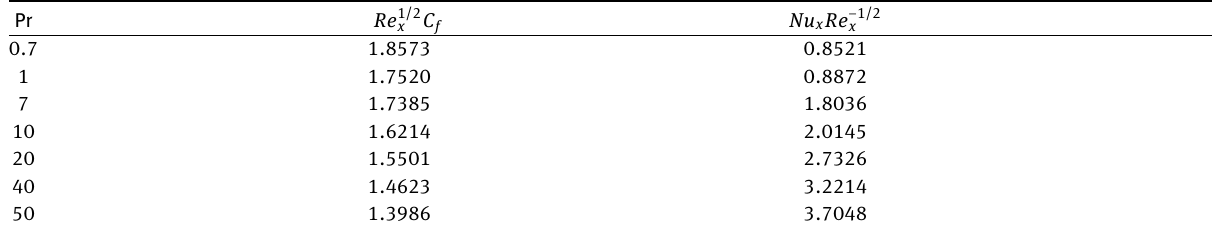
Table 4: The values of skin friction coefficient and local Nusselt number for alumina-sodium alginate nanofluid with various values of Pr when A = 0, ε = 0, M = 0, U = 0, ϕ = 0, λ = w